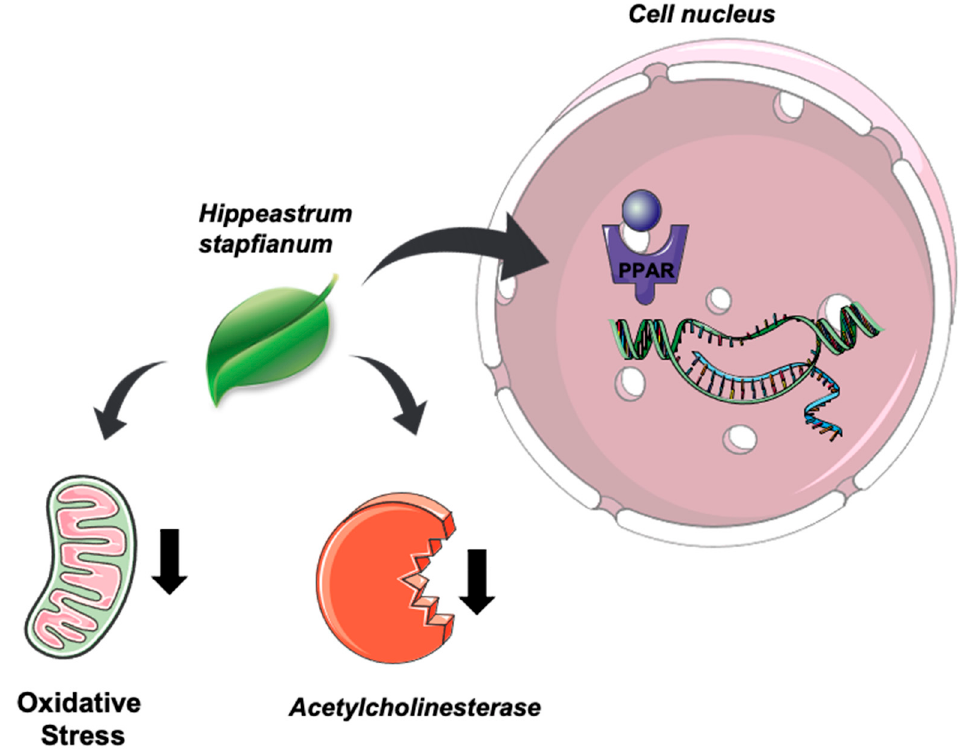
Figure 5. Schematic representation of H. stapfianum leaves modulating positivity the PPAR recep- tors, as well as the acetylcholinesterase downregulation and oxidative stress decrease (Servier Med- ical Art by Servier is licensed under a Creative Commons Attribution 3.0 Unported